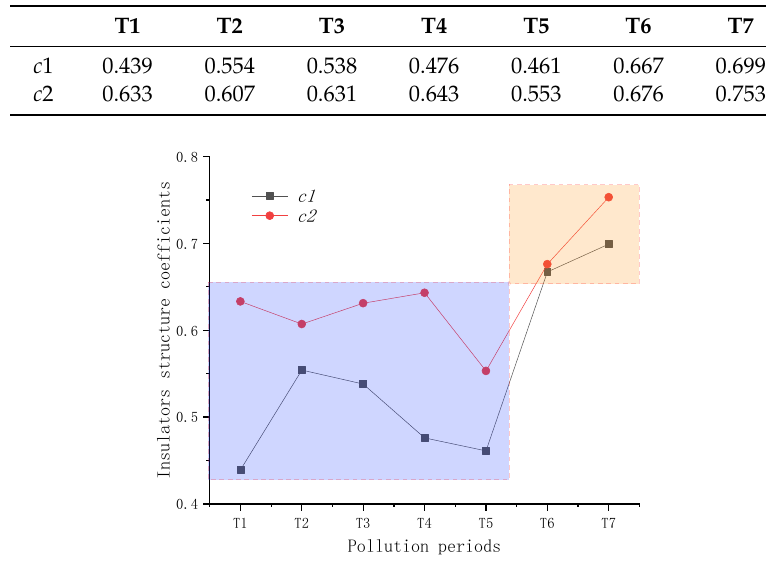
Figure 9. Insulator structure coefficients.